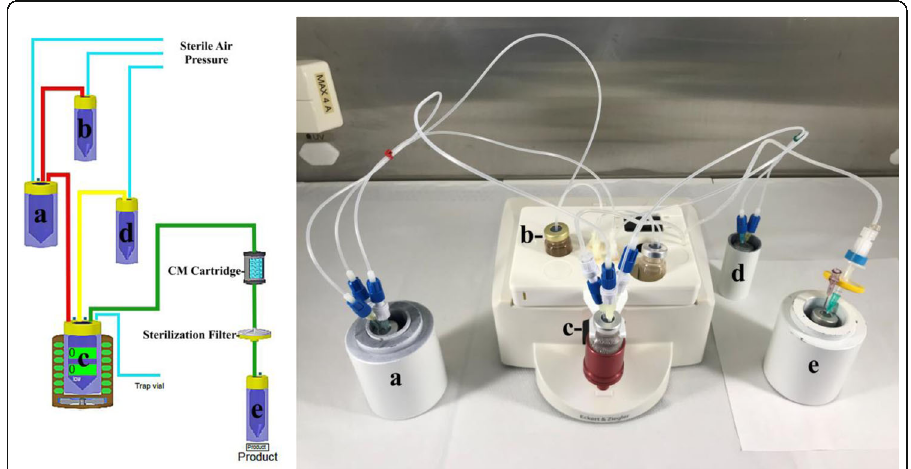
Fig. 3 ML-Eazy fully automated synthesis device, disposable cassette and schematic flow ( a ) [ 177 Lu] Lu vial, ( b ) Buffer and peptide vial, ( c ) Reaction vial and heater, ( d ) Saline vial, ( e ) Final product